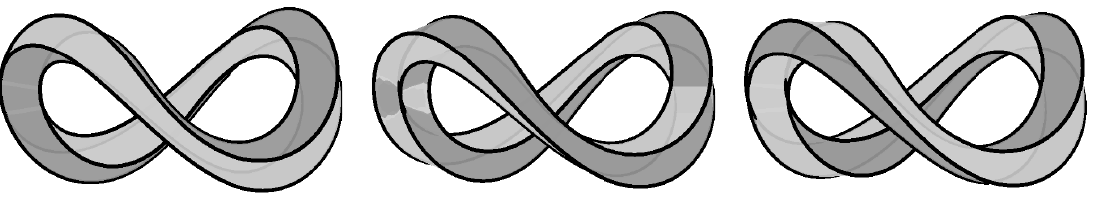
Figure 8. Three square tubes with length 25nm and constant thickness 1nm around a tennis ball curve with b = a /20. In the middle plot, the case with one quarter turn is shown. To the right with one half